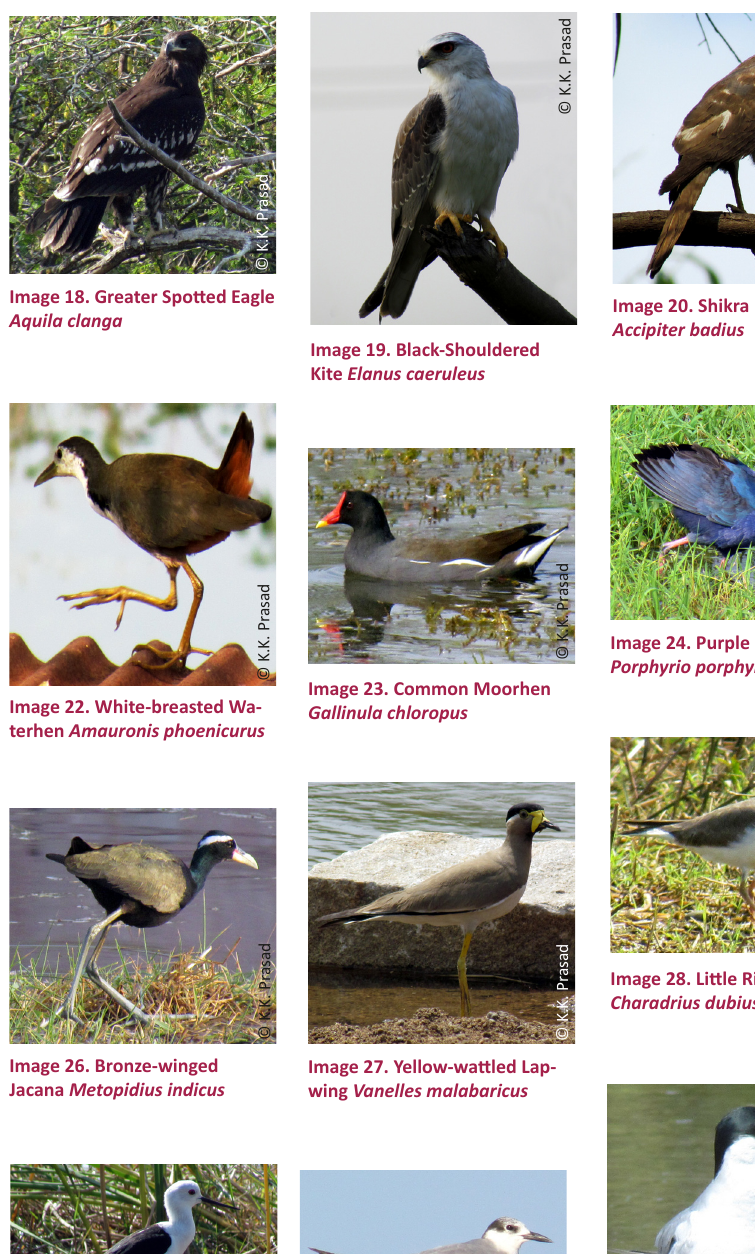
Image 32. River Tern Sterna aurantia